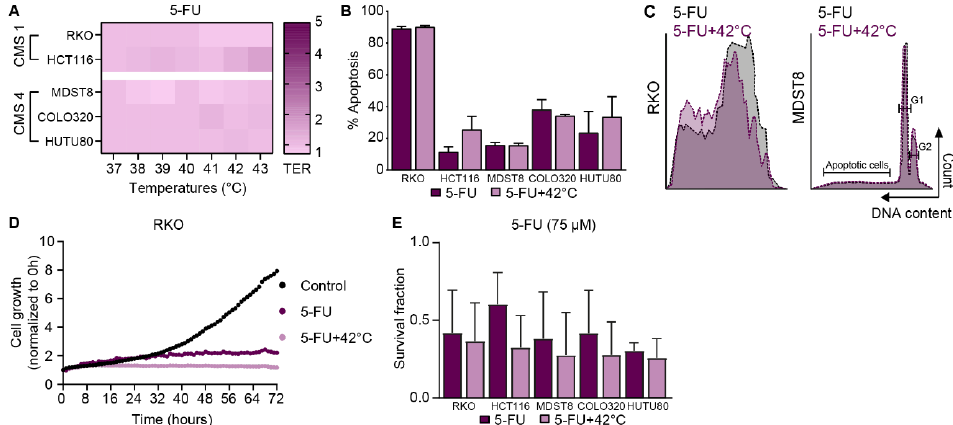
Figure 4. 5-Fluorouracil (5-FU), as a systemic drug in combination with hyperthermic